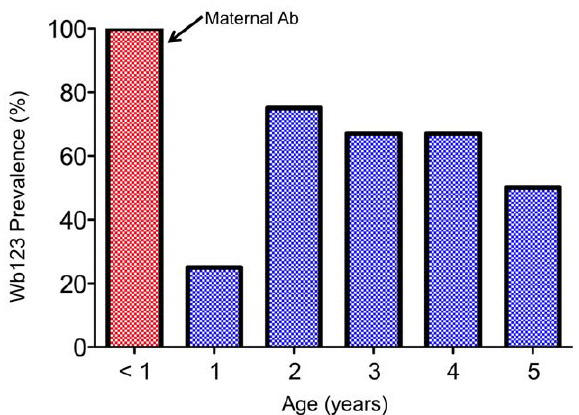
Figure 5. Prevalence of Ab to Wb123 in Young Children. Prevalence of Ab to Wb123 (i.e. the percent positive for Ab) in children # 5 years old in 1975. The red bar for children , 1 year presumably indicates the presence of maternal Ab.